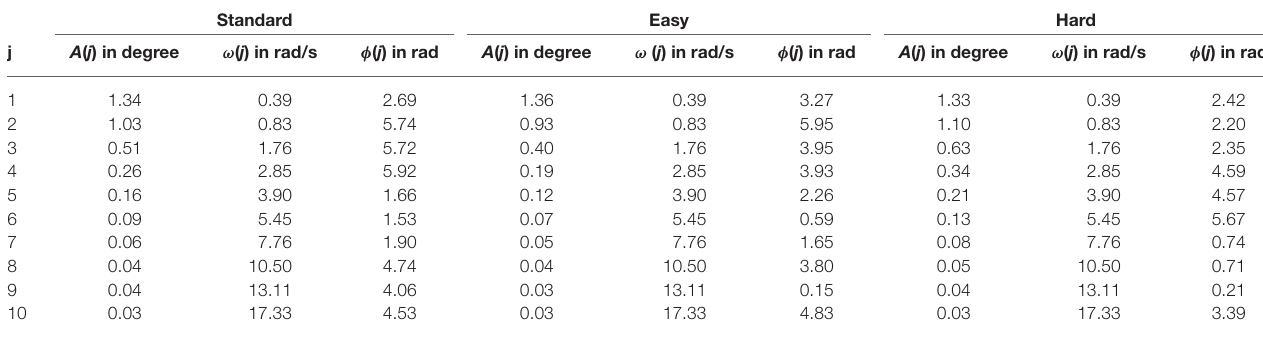
TABLE 1 | Amplitude A ( j ), frequency ω ( j ) and phase φ ( j ) of the ten sine waves, contained in the forcing function, for the “standard”, “easy” and “hard” condition.